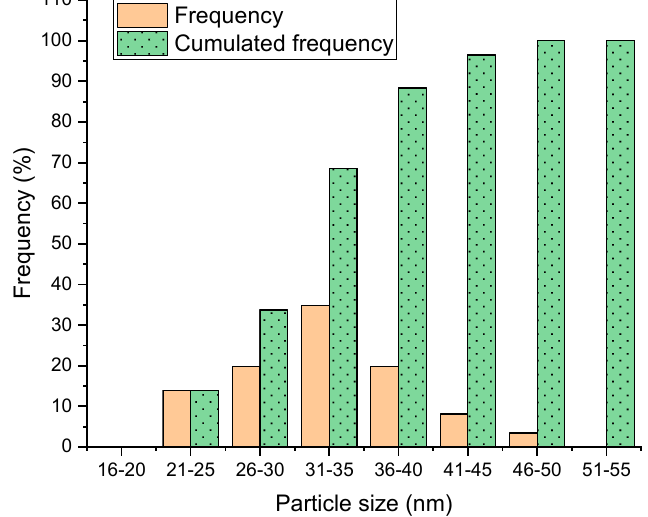
Figure 4. Size distribution of the nanoparticles for sample #3.